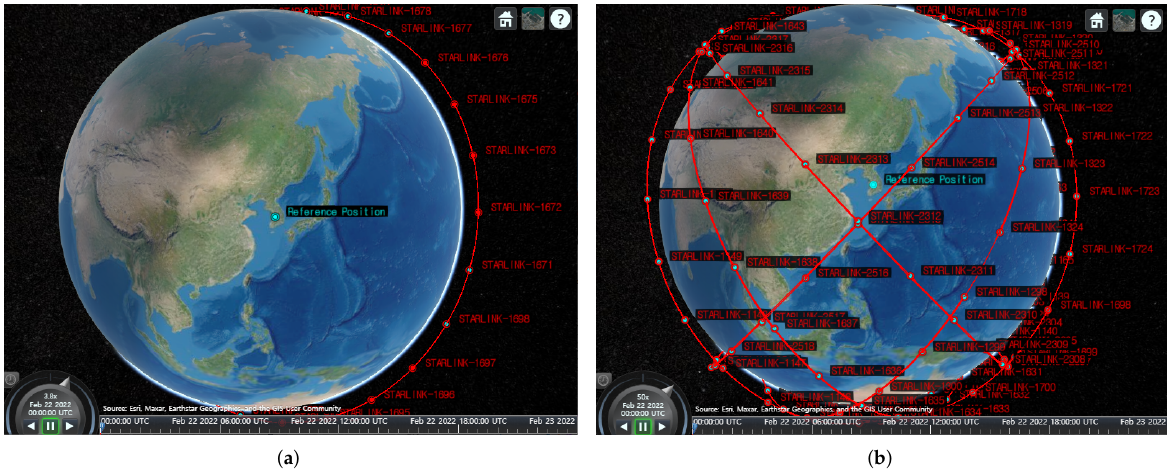
Figure 14. 3D satellite orbits implemented in MATLAB [44]. ( a ) one orbit (27 satellites), ( b ) six orbits (162